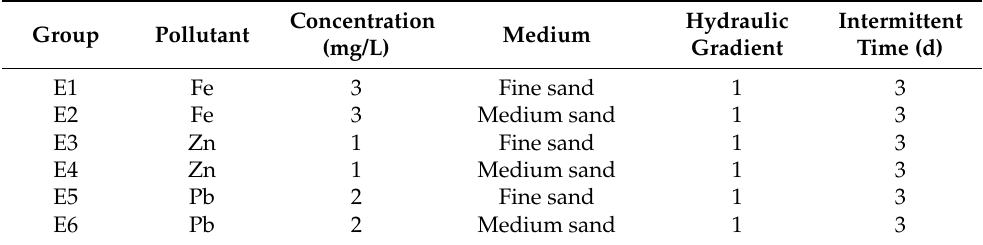
Table 3. Pollutant migration design under different